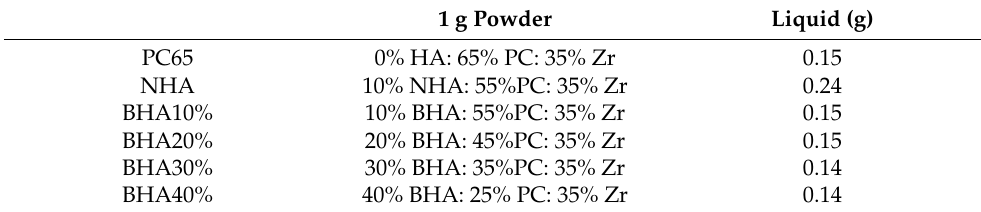
Table 1. Cement powder ratios/liquid ratios per